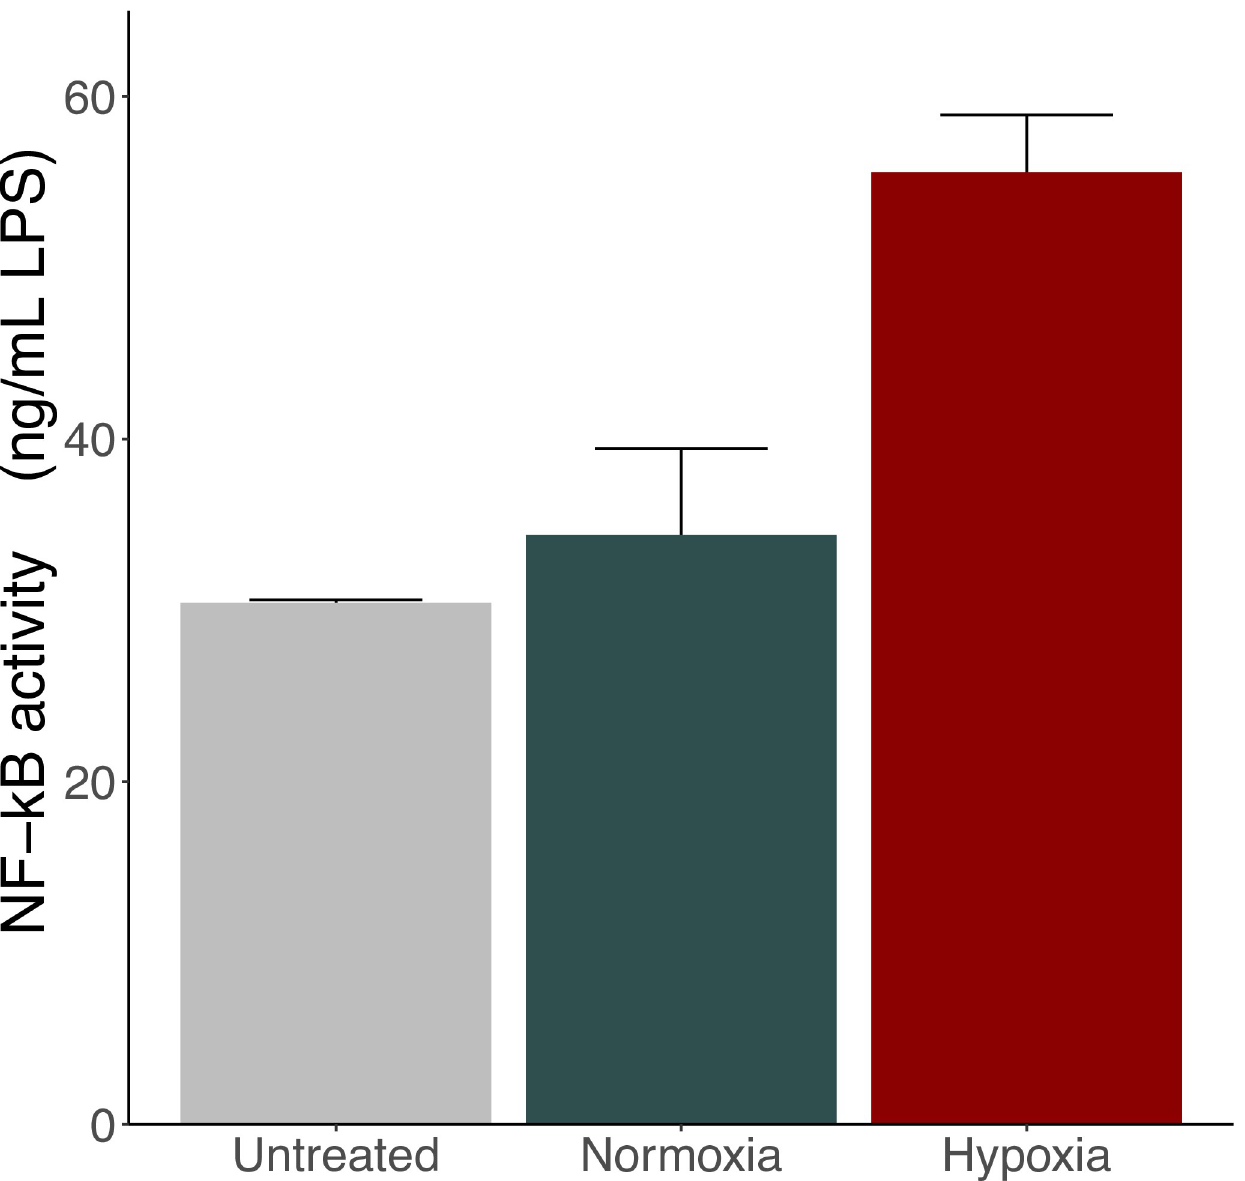
Fig 2. Effect of intestinal epithelial cell-derived exosomes on NF- κ B reporter activation in THP-1 monocytic cells. The supernatants of the normoxia and hypoxia groups were harvested, and the exosome compartment was extracted. THP-1 Blue NF- κ B cells were identically stimulated by the obtained exosomes. The black bar indicates the exosomes obtained from the normoxia group, the red bar indicates the exosomes obtained from the hypoxia group, and the gray bar indicates exosomes obtained from the negative control using 10% (v/v) sterile PBS. Results are expressed as mean ± standard deviation of three experiments. NF- κ B, nuclear factor-kappa